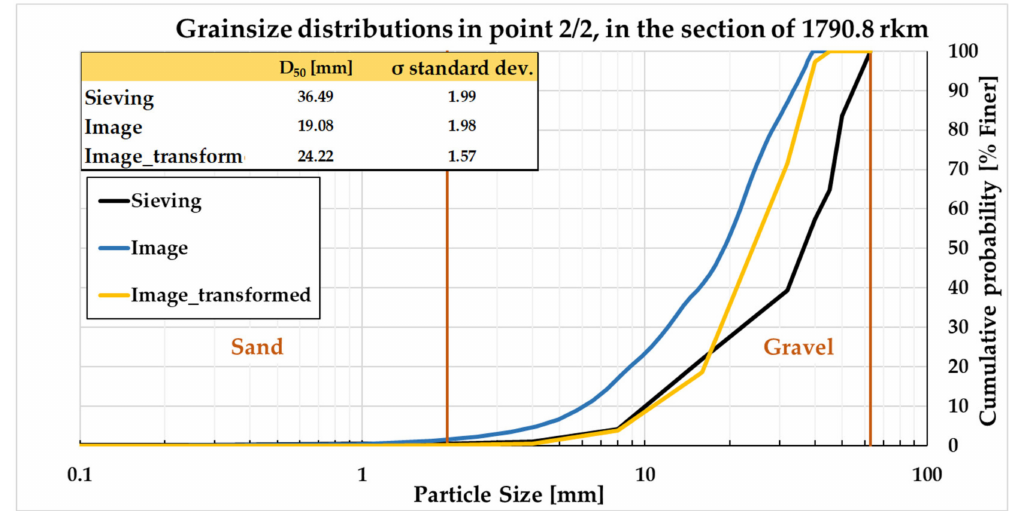
Figure 9. Size distributions of sampling point 2 / 2. The image-based distribution showed a better match only after transformation.